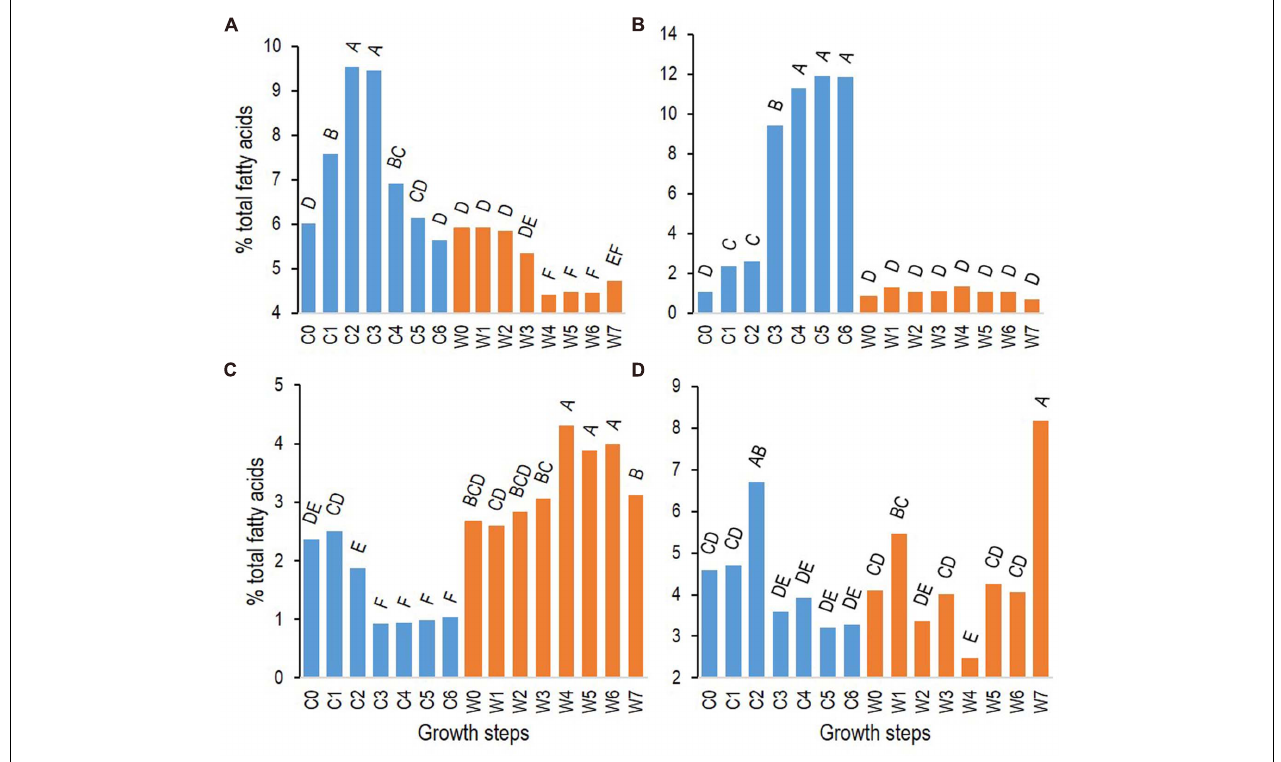
FIGURE 5 | Changes of relative abundance at cold (12 ◦ C, C0–6, blue bars) and warm (30 ◦ C, W0–7, orange bars) temperatures of fatty acids with representative patterns of changes (see Table 2 ): i13 (A) , n16:2 (cid:49) 5 , 10 (B) , i16:1 (cid:49) 10 (C) , and n16 (D) . Results presented are from B. cereus strain ATCC 10876. Growth